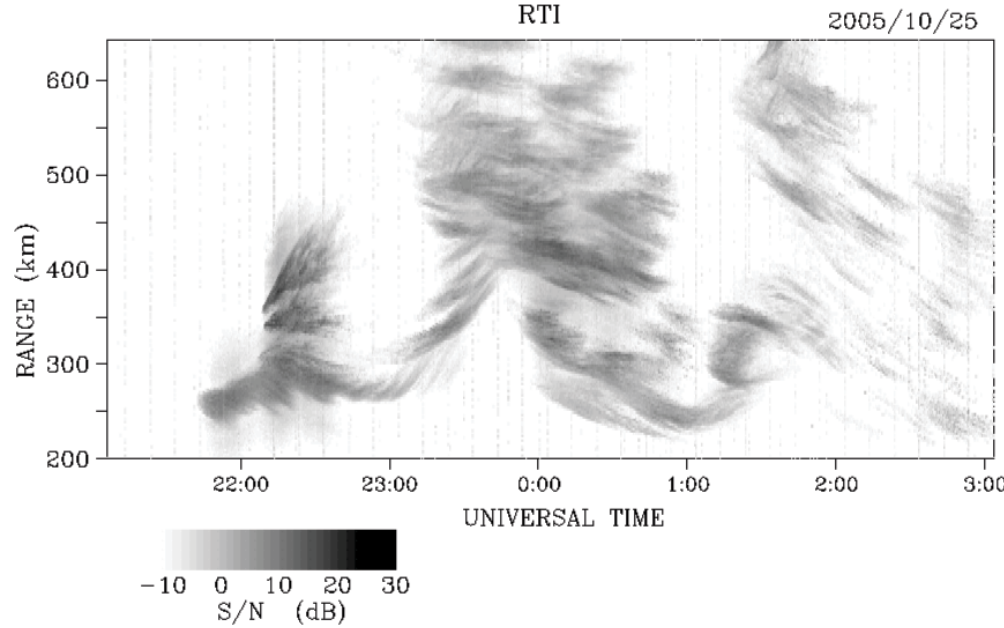
Fig. 2. Range-Time-Intensity (RTI) map for 25 October 2005 (UT ≈ LT+3)